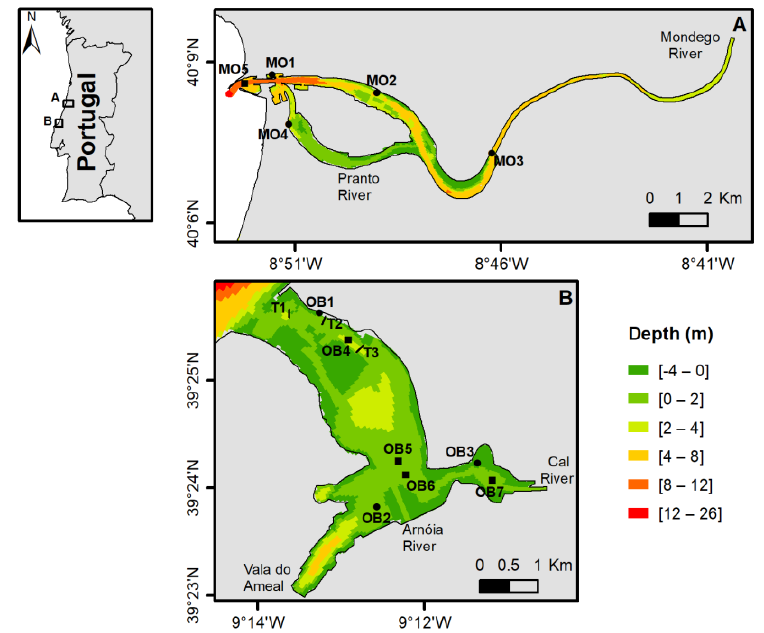
Figure 1. Bathymetry of Mondego Estuary ( A ) and Ó bidos Lagoon ( B ), with the location of the sampling stations for hydrodynamic variables (black dots) and water quality variables (black squares).